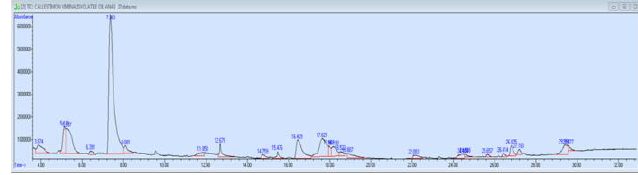
Figure. 2: The GC-MS chromatogram for essential oil extract